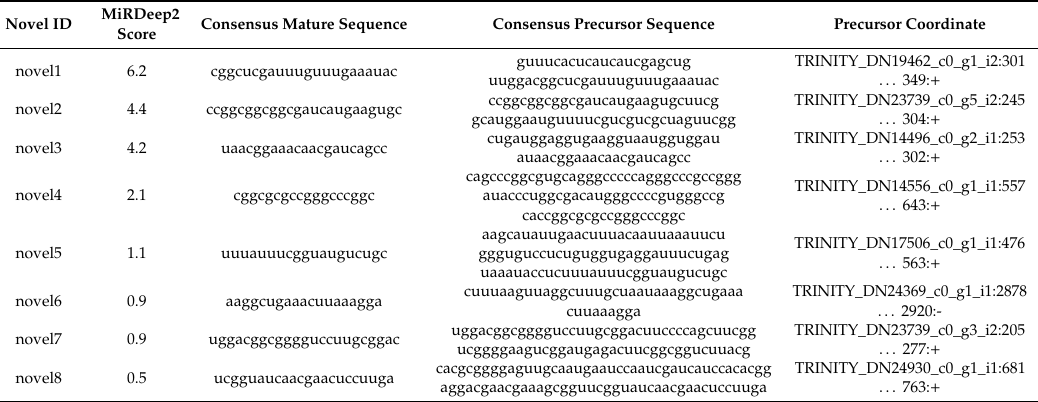
Table 3. List of novel miRNAs identified in P. cristata